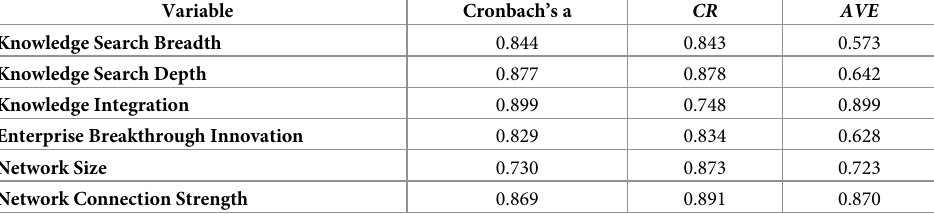
Table 3. Reliability and convergent validity of the